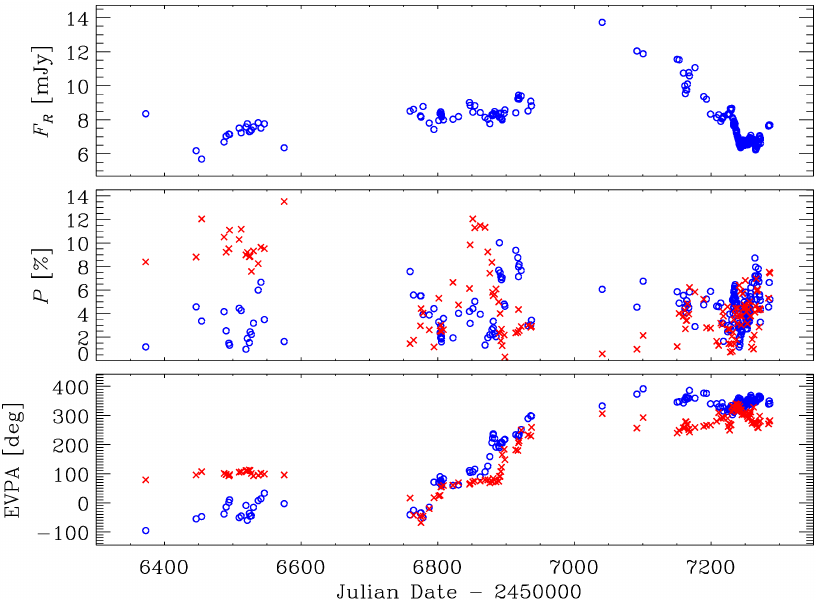
Figure 2. ( Top ): The R -band flux densities of PG 1553 + 113 during the period 2013–2015. ( Middle ): The polarisation degree. ( Bottom ): The optical EVPA. The blue circles represent the observed quanti- ties, while the red crosses refer to the result of the Monte Carlo simulations involving 220 emitting cells with a uniform and randomly oriented magnetic field. Figure adapted from